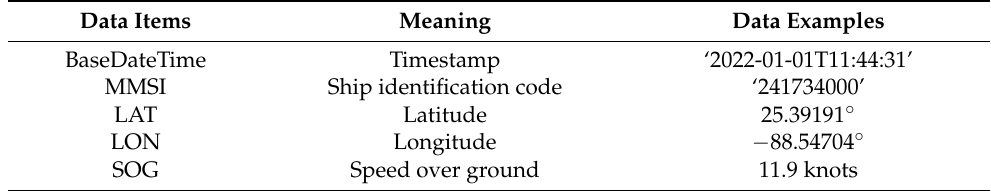
Table 1. Example of AIS data